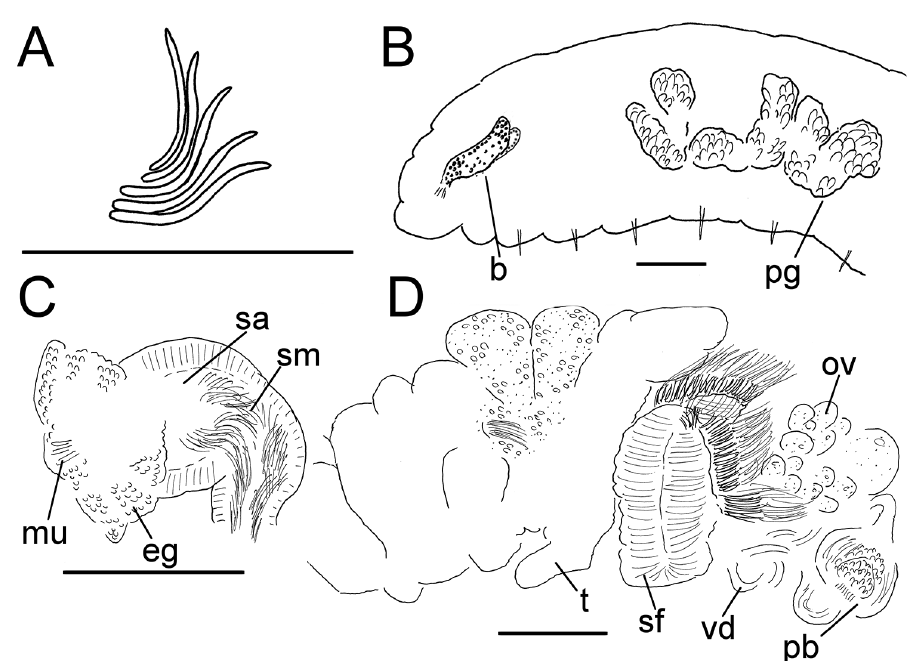
Figure 10. Lumbricillus sp. F. A Chaetal bundle B Anterior body C Spermatheca D Other genitalia. Abbreviations under general notes. Scale bars: 100